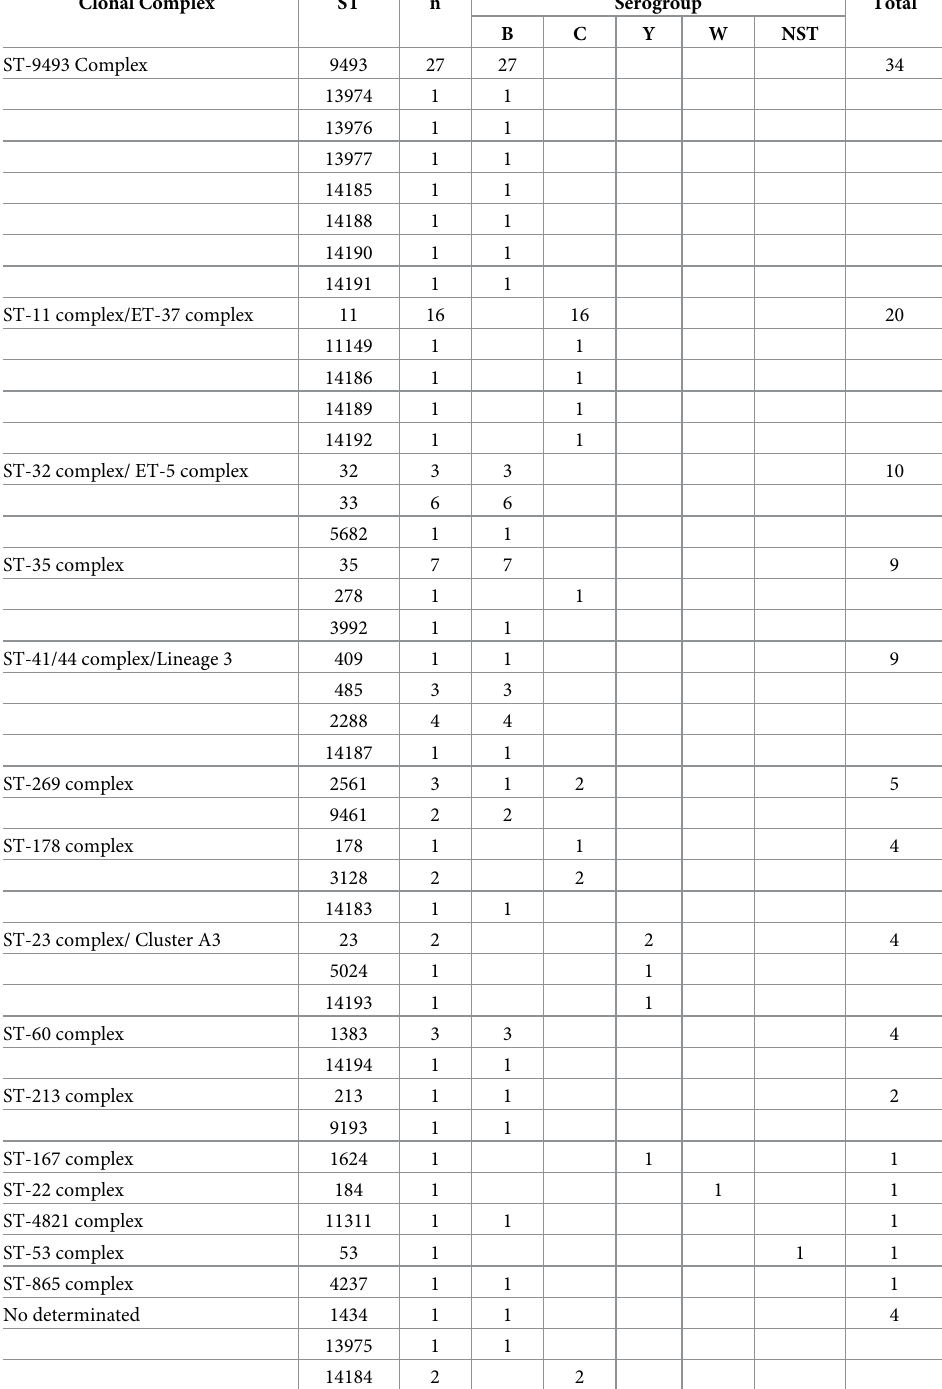
Table 2. Distribution of clonal complexes, sequence types (ST) and serogroups of the isolates received in the sur- veillance program in Colombia from